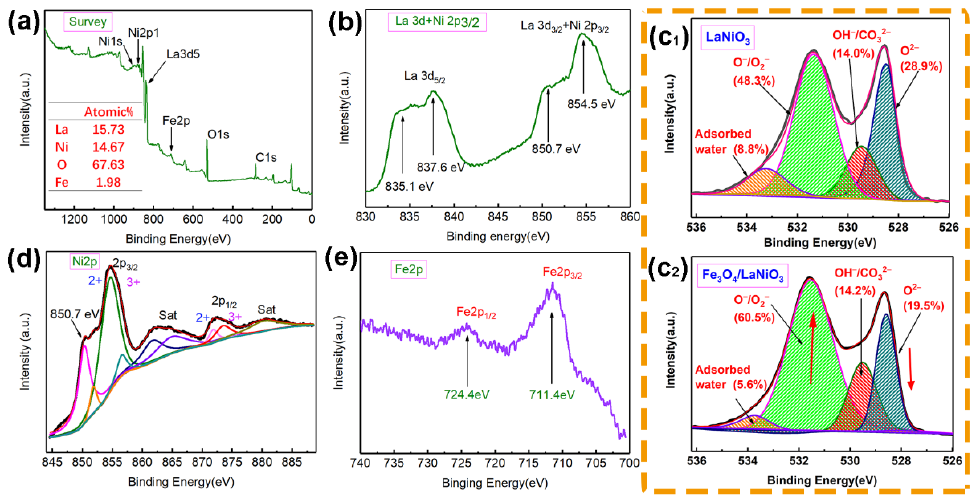
Figure 3. XPS spectrum of Fe 3 O 4 /LaNiO 3 catalyst: ( a ) full spectrum; ( b ) La 3d; ( c ) O1s; ( d ) Ni 2p; ( e ) Fe 2p.